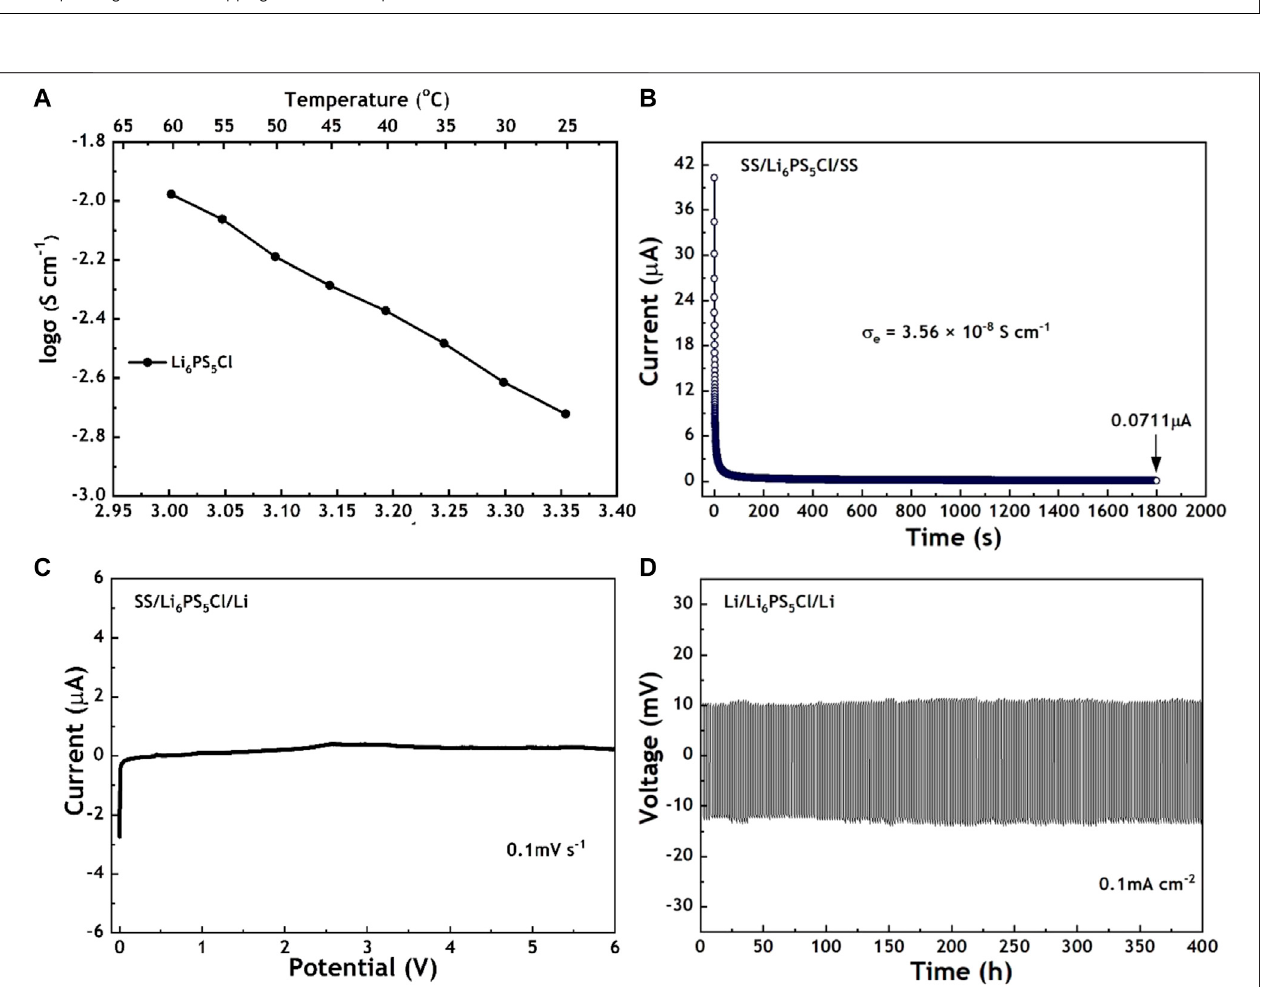
FIGURE 3 | (A) Temperature dependence of the ionic conductivity of Li 6 PS 5 Cl (B) DC polarization of a blocking SS/Li 6 PS 5 Cl/SS cell (C) LSV curve of the SS/ Li 6 PS 5 Cl/Li cell (D) Voltage pro fi le of the symmetric Li/Li 6 PS 5 Cl/Li cell at 0.1 mA cm − 2 .